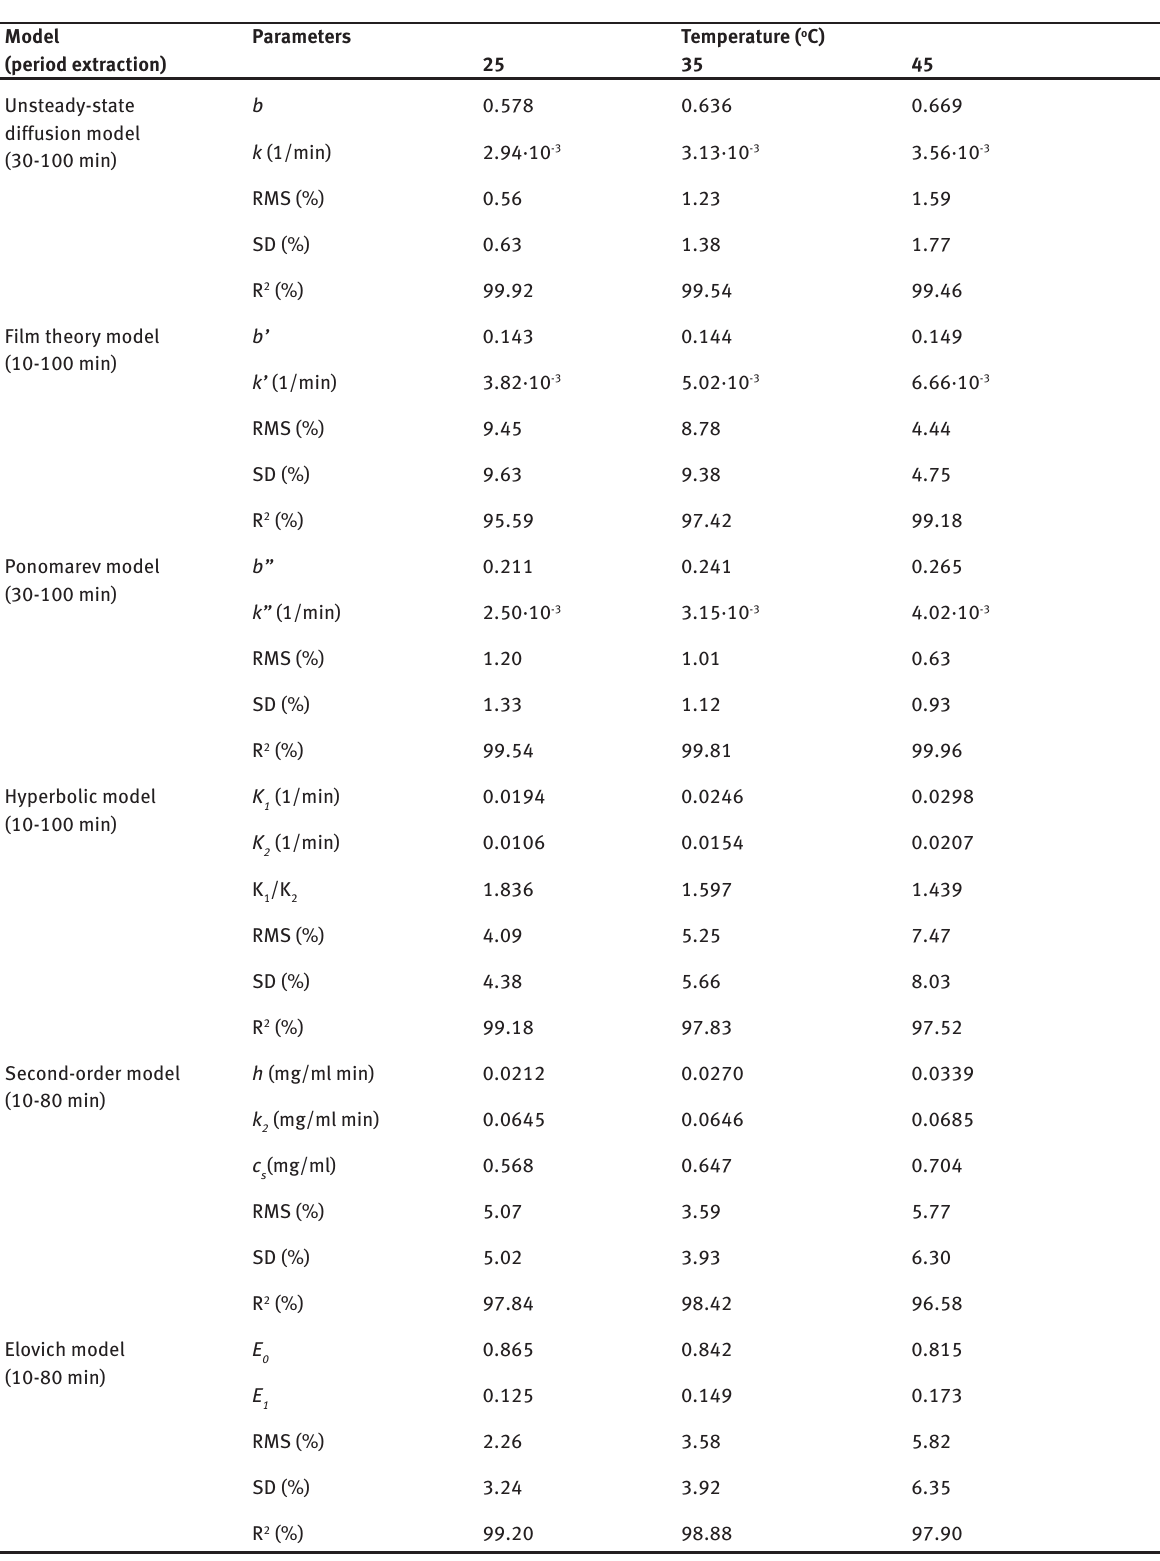
Table 2: The statistical values of various kinetic models for extraction of vanillic acid from pumpkin seeds.